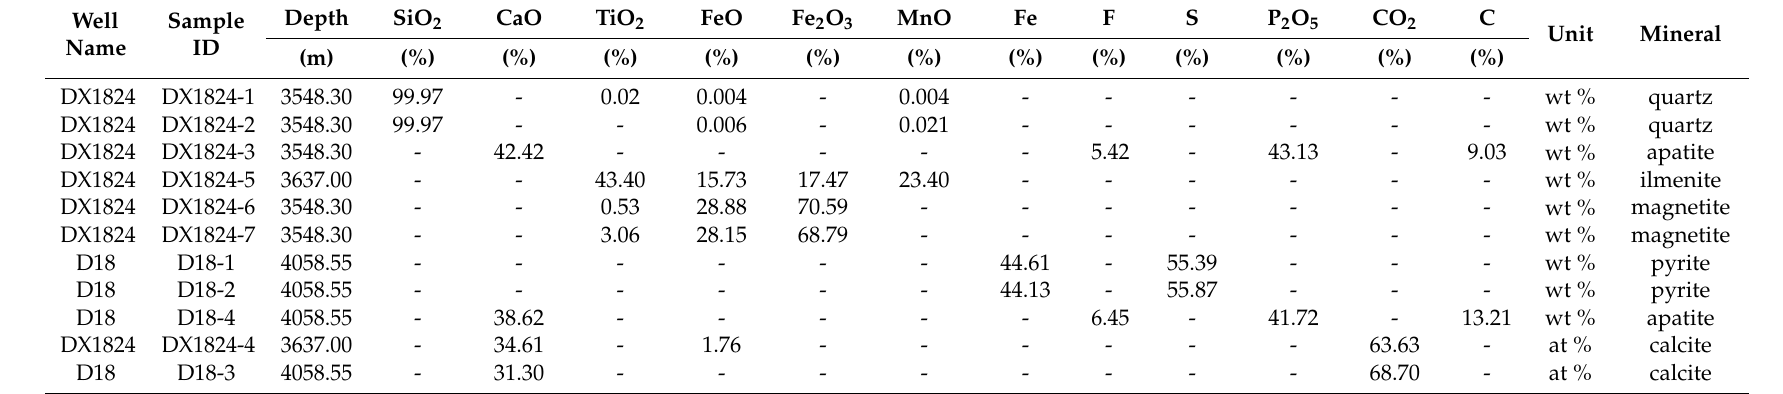
All data are normalized to 100. - indicates no available